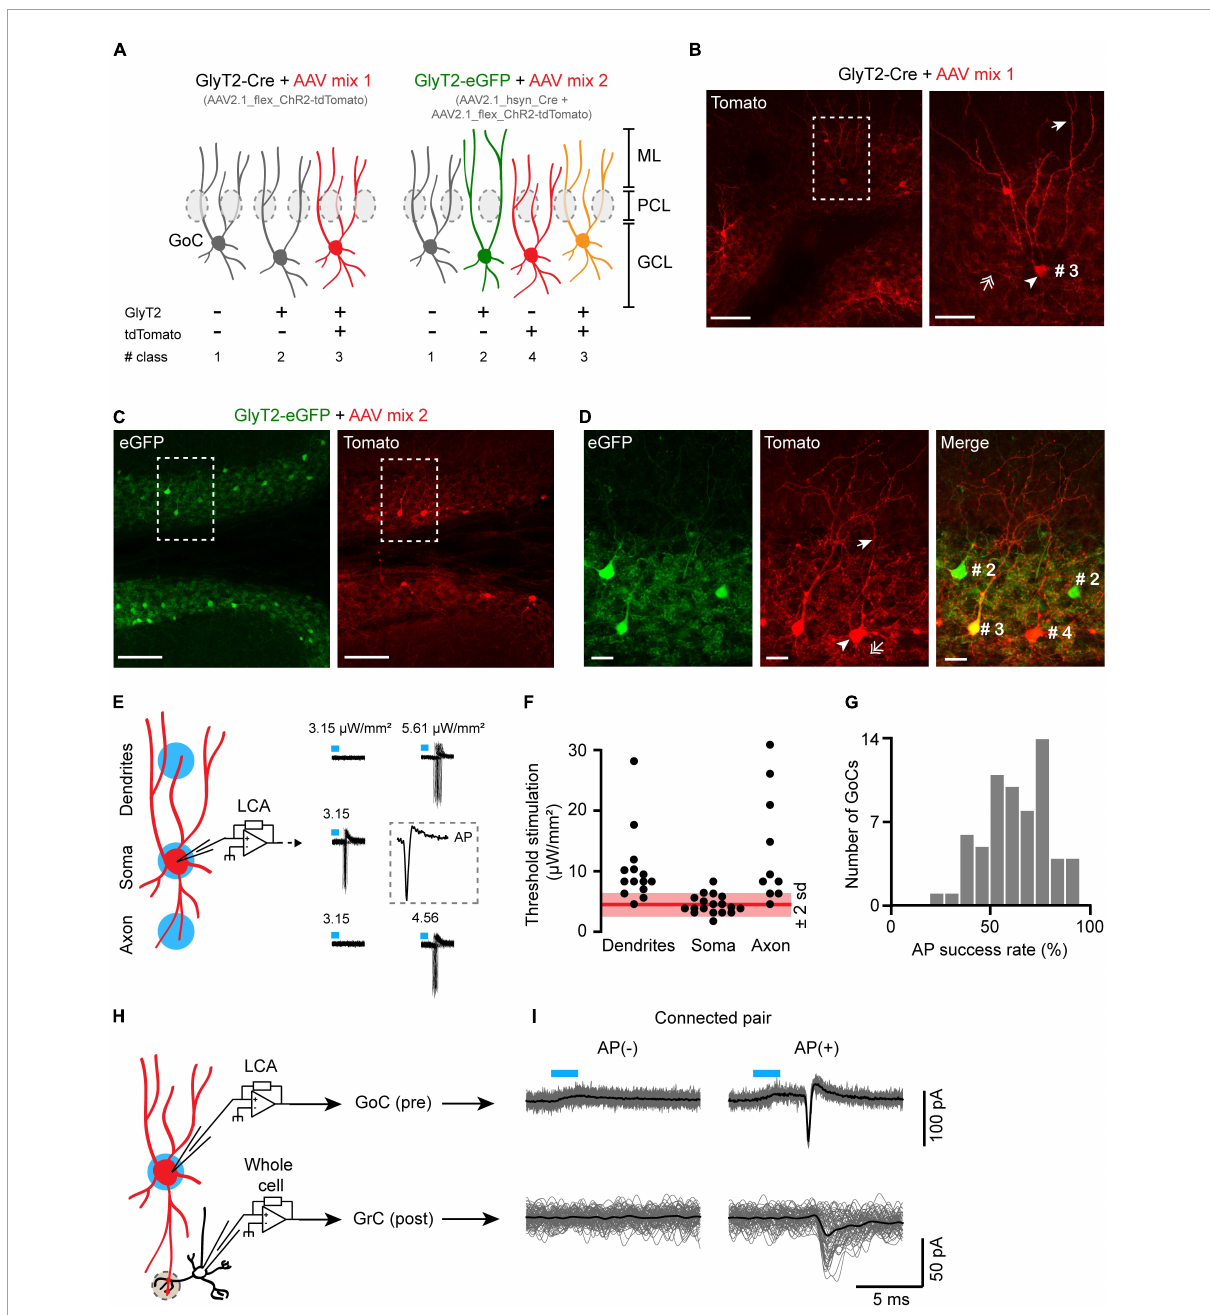
FIGURE2 A targeted optogenetic stimulation strategy for GoC-GrC paired recordings without presynaptic dialysis. (A) Schematic of the viral strategies to express the channelrhodopsin (ChR2) fused with the tdTomato as reporter in GlyT2(+) and GlyT2( − ) GoCs. GCL, granular layer; PCL, Purkinje cells layer; ML, molecular layer. (B) Slice of a representative GlyT2-Cre mouse injected with the mix 1 of AAV. Left panel, apex of the lobule IV showing infected, tdTomato(+) GoCs. Scale bar: 100 µ m. Right panel left panel magnification showing the characteristic GoCs morphology. Arrowhead: soma; arrow: apical dendrite; double arrow: axons. Scale bar: 20 µ m. (C) Same as panel (B) for a GlyT2-eGFP mouse injected with the mix 2 of AAV. Scale bar: 100 µ m. (D) Magnification of panel (C) . (#2 and #3): GlyT2(+) GoC; (#4): GlyT2( − ) GoC. Scale bar: 20 µ m. (E) Left panel, calibration of the optogenetic stimulation power (in blue) to reach > 80% of AP success (Threshold stimulation). Right panel, threshold stimulation power at the soma, dendrites, and axons of a representative GlyT2-Cre(+) GoC. Insert, magnification of an AP evoked at the soma. (F) Populational distribution of the threshold stimulation power (dendrites n = 13, soma n = 18, axons n = 10). In red, mean power at the soma ± 2 SD. (G) Histogram of AP success rate evoked by somatic subthreshold stimulation in connected and unconnected GlyT2(+) and GlyT2( − ) GoCs ( n = 64). (H) Schematic of the GoC-GrC optogenetic pairs recording of the GABAergic transmission in cerebellar glomeruli (gray dotted circle). (I) Representative example of a specifically connected GoC-GrC